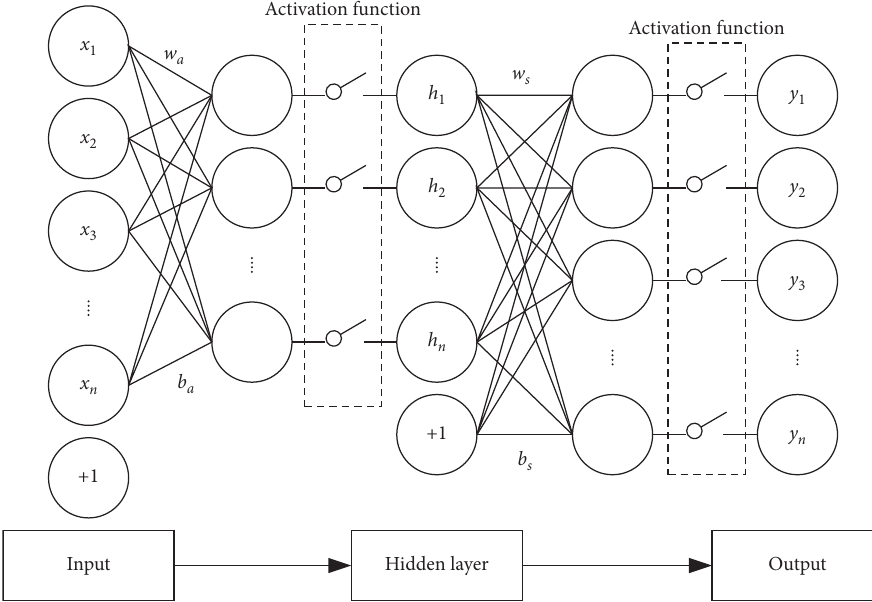
Figure 1: The network structure of the autoencoder.